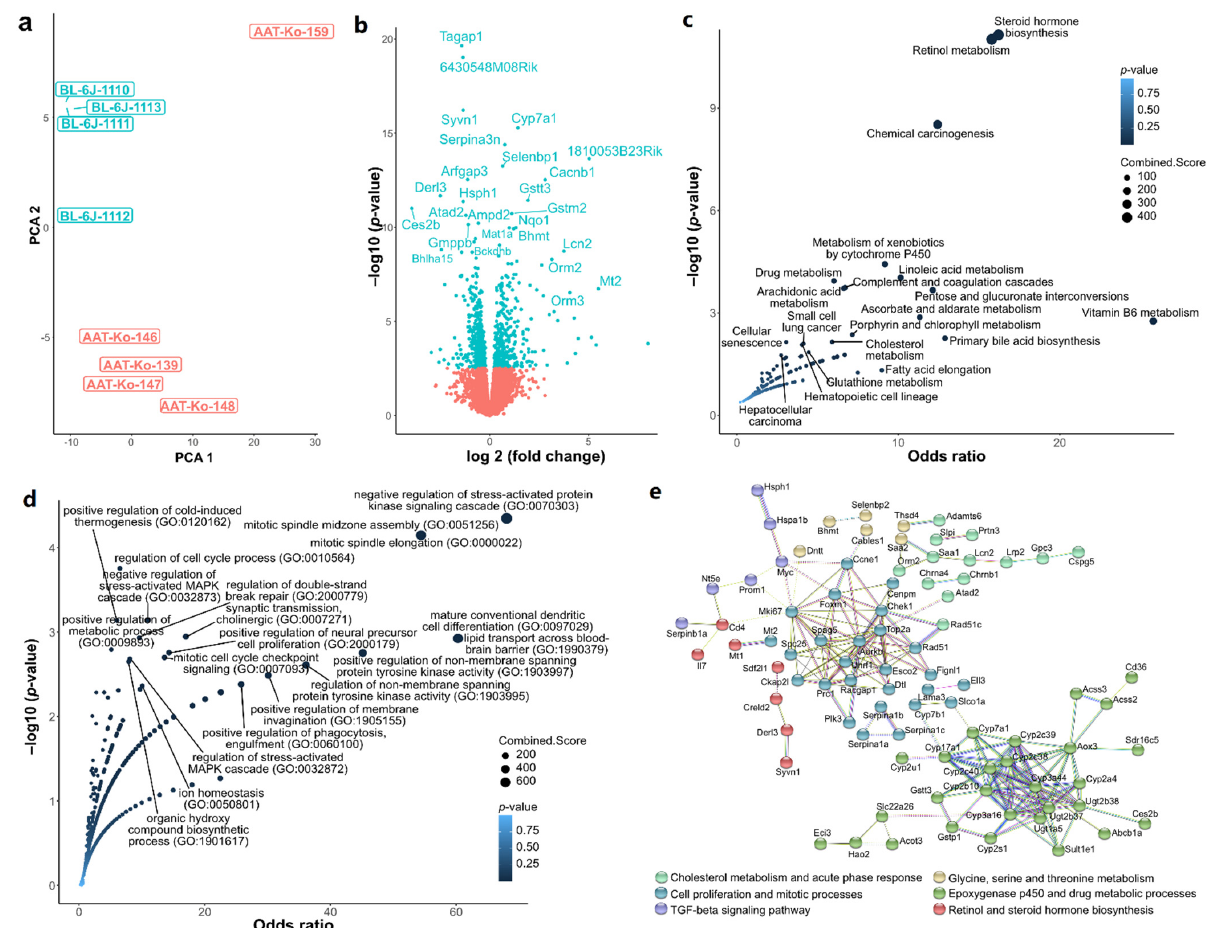
Figure 1. Differential gene expression (DEGs) and pathway analysis of Serpina1 KO vs. WT. ( a ) Principal component analysis of samples selected for RNA-Seq data analysis and DEG exploration with WT labeled blue and KO labeled red. ( b ) Volcano plot of DEGs where x-axis represents the log 2 fold _change and y-axis represents the significance level wherein p- values have been − log 10 transformed. Significantly expressed genes are labeled blue ( p -value ≤ 0.05), and non-significant genes are labeled in red. ( c ) A plot showing the KEGG pathways that were identified from DEGs between KO vs. WT mice using EnrichR. X-axis: odds ratio, Y-axis negative Log 10 p- value. ( d ) Gene ontology analysis using EnrichR: x-axis: odds ratio, y-axis negative Log 10 p -value. ( e ) Protein-protein interaction networks as generated with String-Db: Differentially expressed genes were subjected to k-means clustering (n = 6) with high confidence interaction settings.